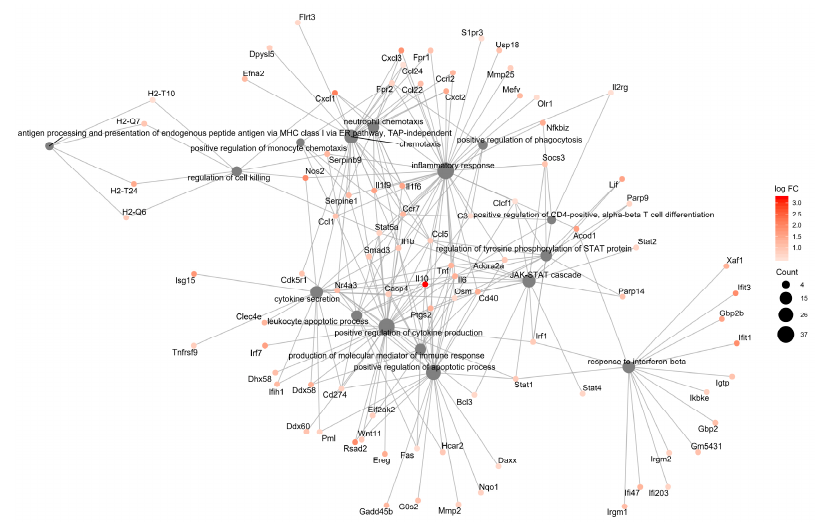
Figure 3. Functional interaction networks related to biological process Gene Ontology terms enriched by genes upregulated in response to P. brasiliensis infection in BMDCs from the resistant mouse strain, A / J. ClusterProfiler was used to generate the functional interaction networks formed by upregulated genes related to the GO Biological Process terms. Dot size represents the number of genes in each GO term.